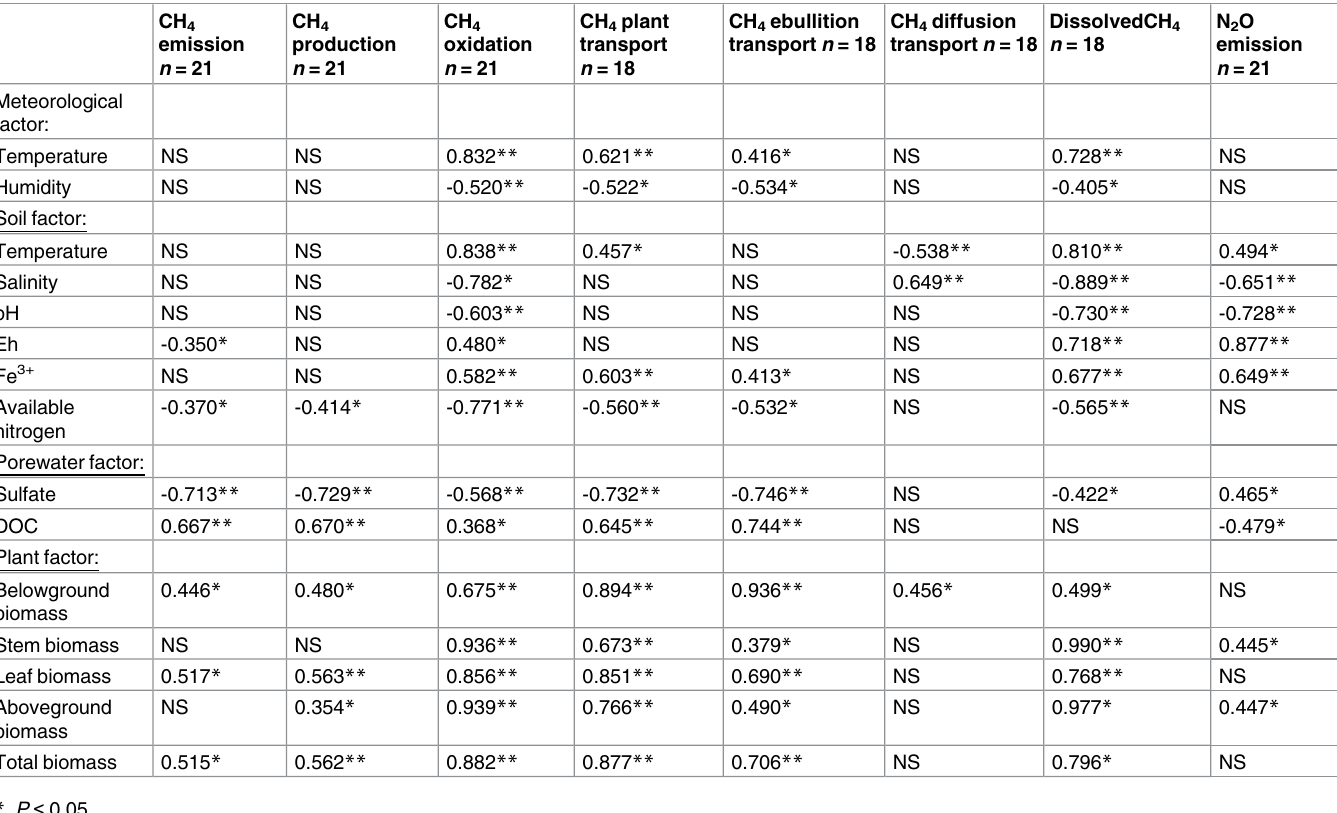
Table 2. Pearson correlation coefficients between CH 4 metabolism, N 2 O emission, and various environmental